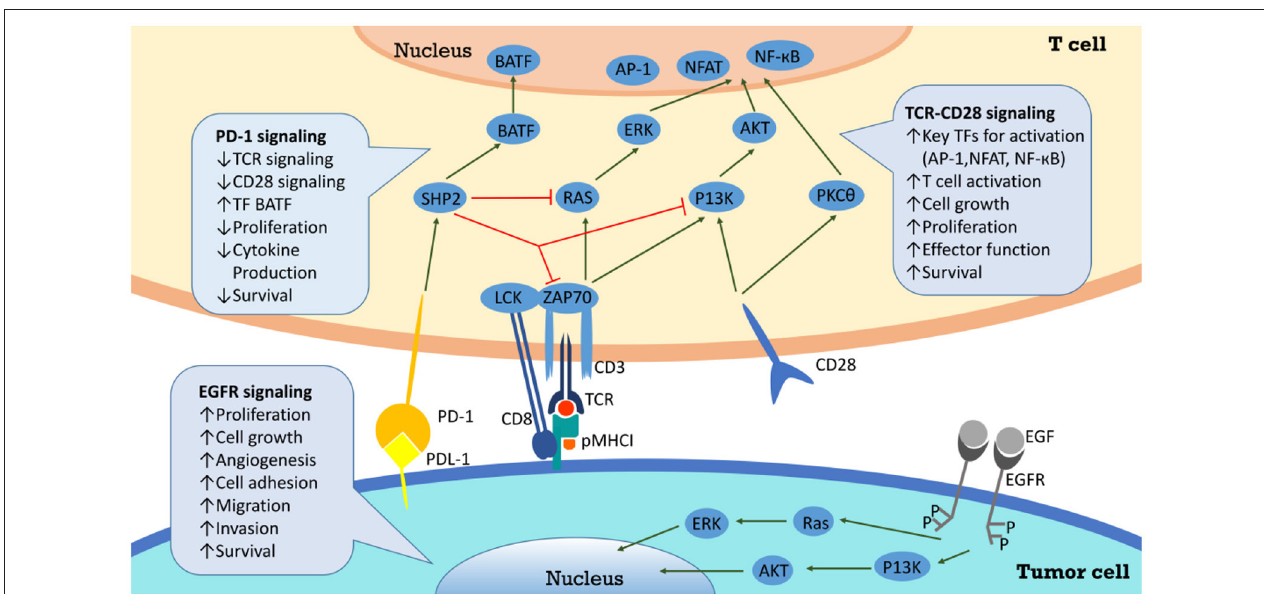
FIGURE 2 | PD-L1/PD-1 signaling pathway and the correlated network. Interaction between PD-L1 and PD-1 on T cells results in inhibition of Zap70 phosphorylation and PI3K activation, and finally attenuates TCR signaling, CD28 mediated co-stimulation, NF- κ B, and AP-1 activation, and IL2 production. Through inhibition of T cell via overexpression of PD-L1, cancer cells evade the host immune system. (NCT01295827) and hematologic malignancies